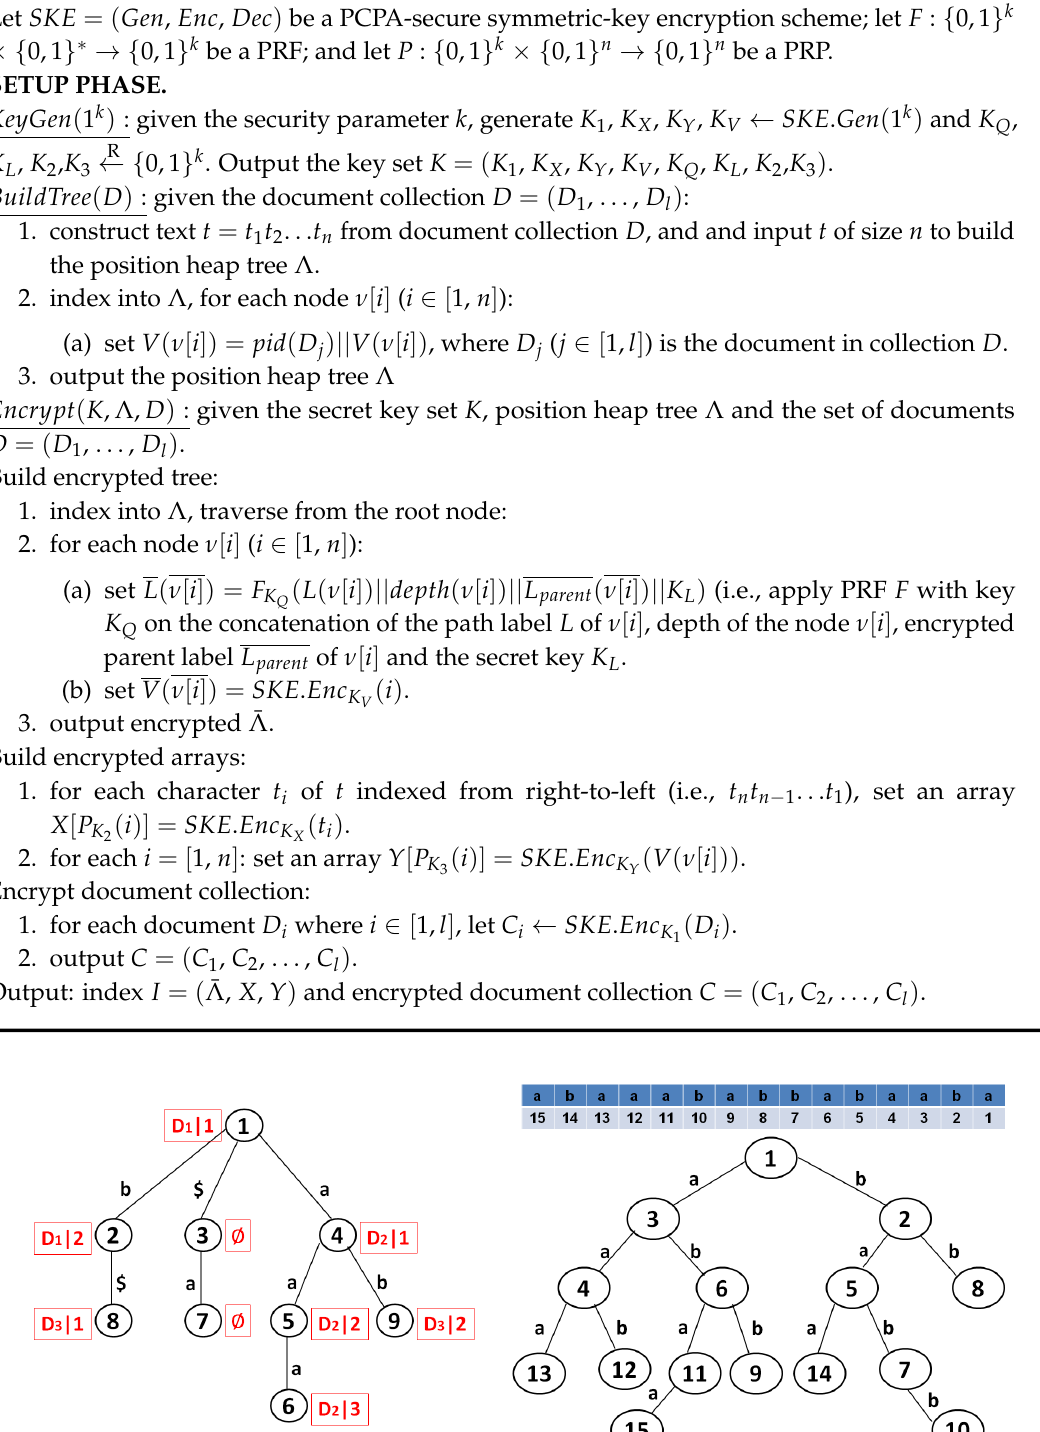
Algorithm 2 : SSP-SSE setup phase.